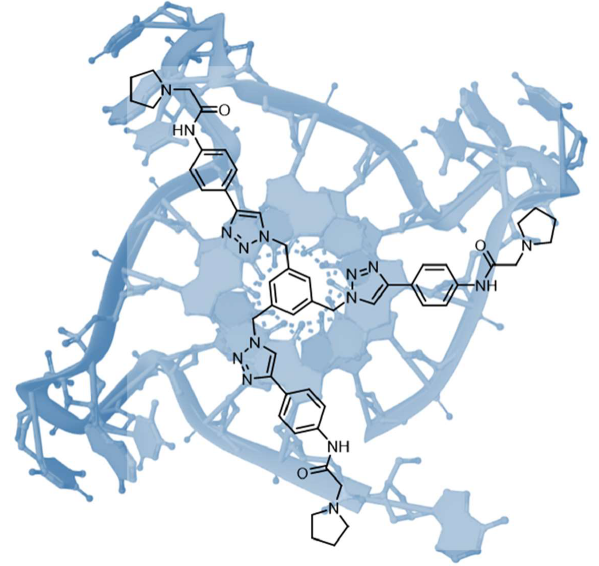
Figure 5. Representation of the C3-symmetric tris-triazole derivate bound to the parallel human telomeric quadruplex structure.